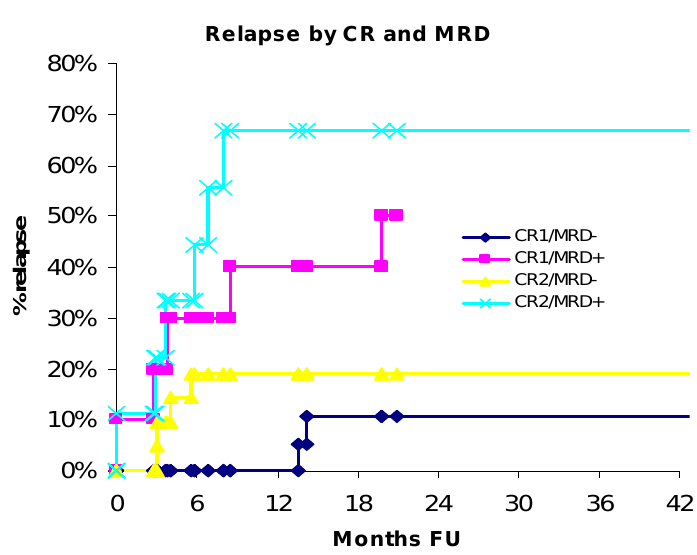
Figure 3. Relapse by CR and MRD. Relapse by CR and MRD